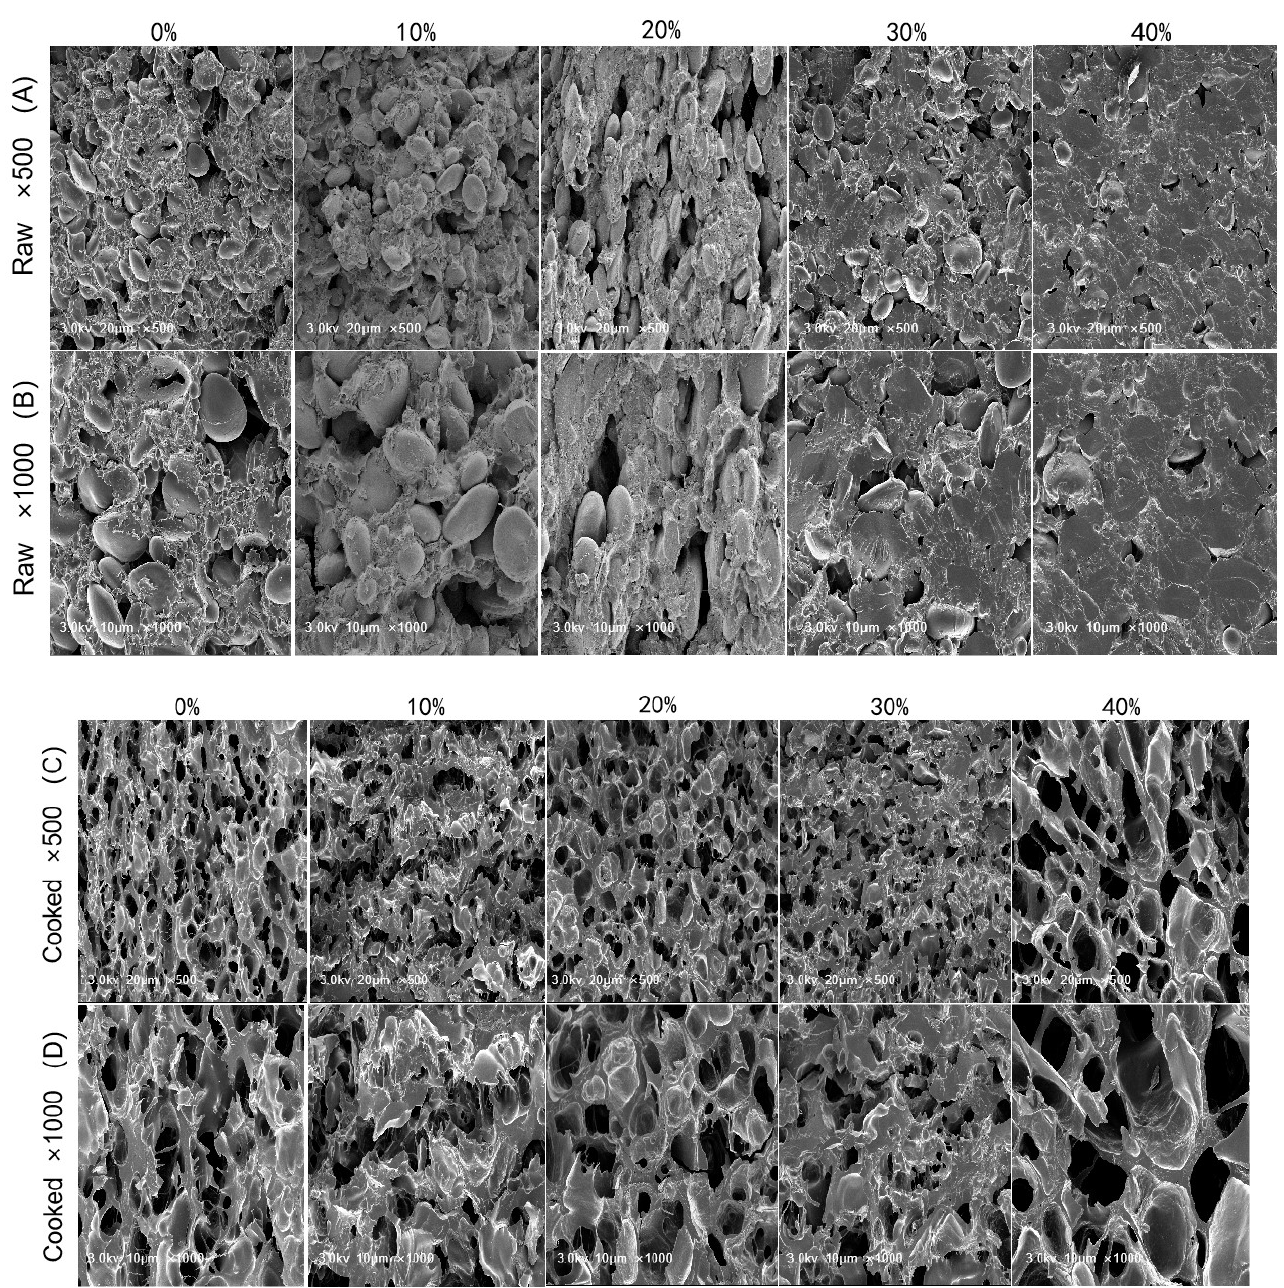
Figure 2. Scanning electron micrographs of noodles substituted with different level of GBP.